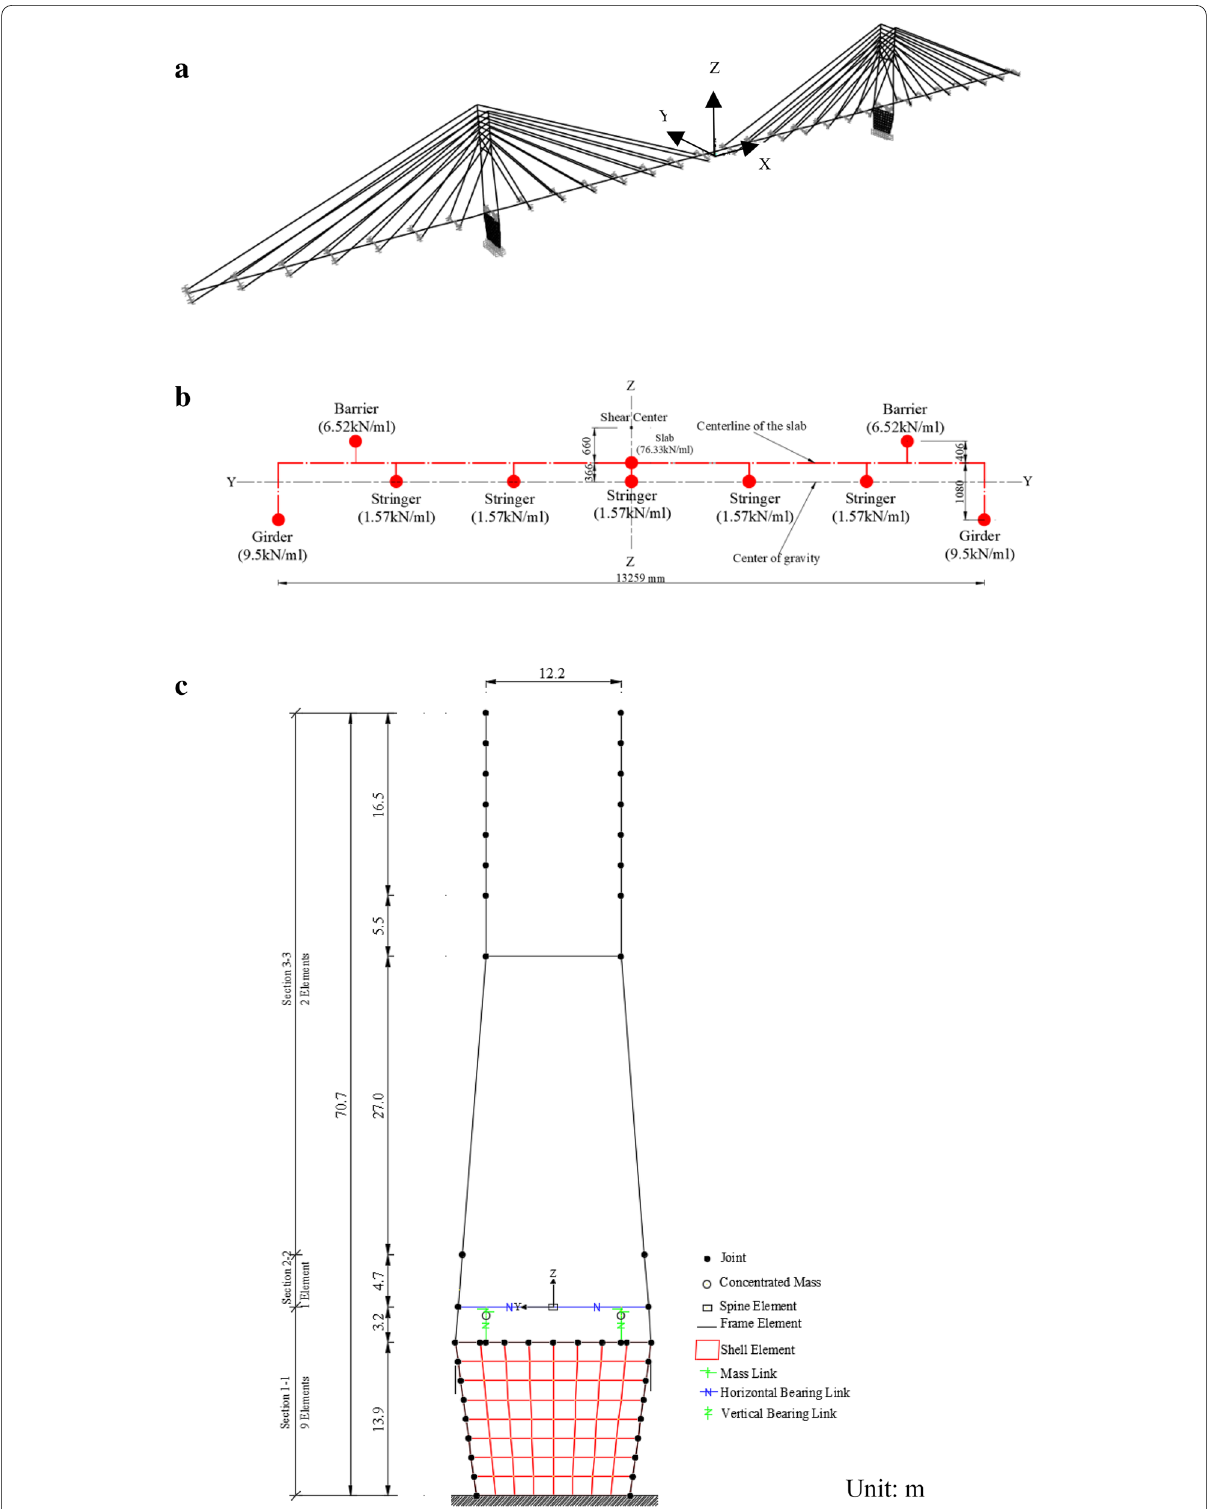
Fig. 2 Finite element model of the bridge: a 3D spine model, b deck, c